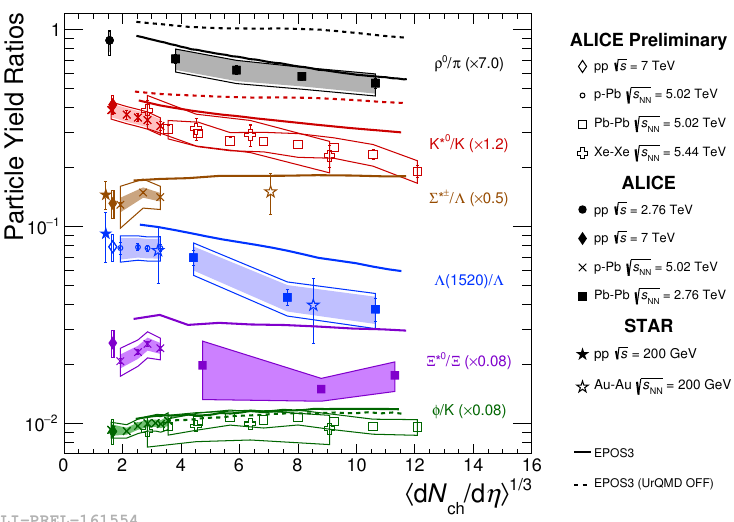
Figure 2. (Color online) p T integrated particle yield ratios ρ / π , K ∗ 0 /K, Λ ( 1520 ) / Λ , Σ ∗± / Λ , Ξ ∗ 0 / Ξ and φ /K as a function of (cid:104) d N ch /d η (cid:105) 1/3 in pp, p–Pb, Pb–Pb and Xe–Xe collisions. The model predictions from EPOS3 (with and without URQMD) are also